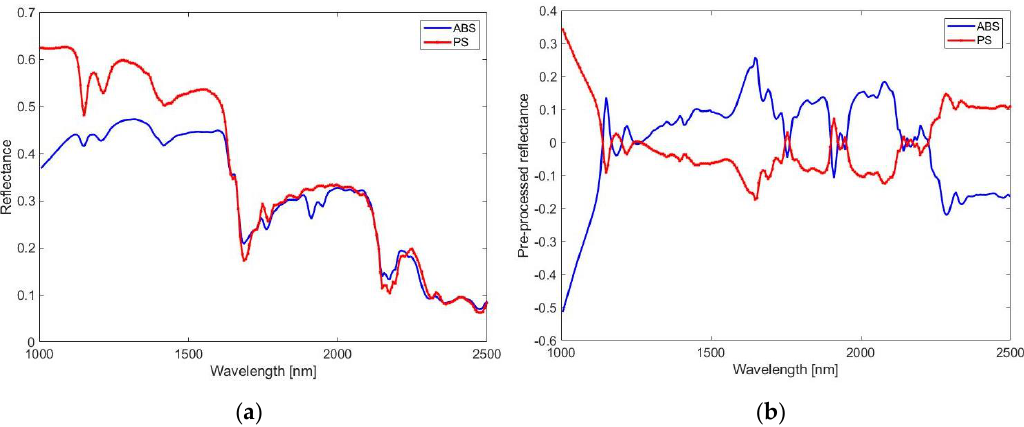
Figure 7. Average raw reflectance spectra ( a ) and preprocessed reflectance spectra ( b ) of the two reference polymer classes (ABS and PS), obtained after ROIs selection on SisuCHEMA XL™ data (wavelength range: 1000–2500 nm).